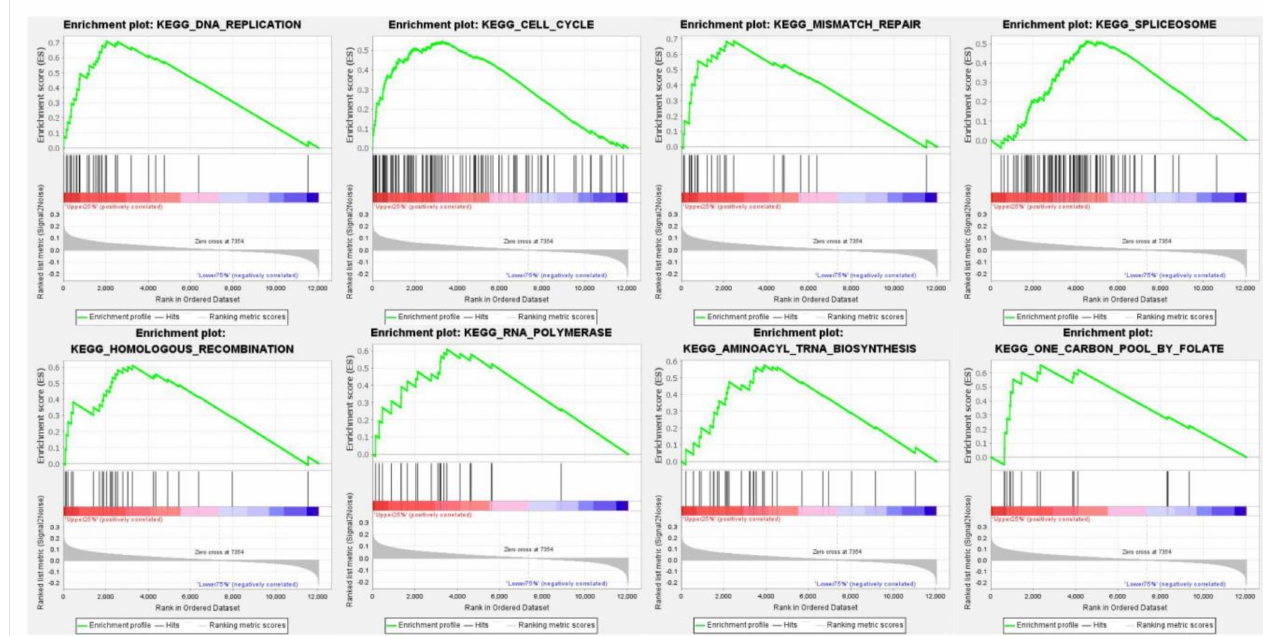
Figure 6. The pathway enrichment analysis of PUS7 in ovarian cancer. GSEA pathway analysis using TCGA ovarian cancer data, which was separated to a high (top25%) PUS7 group and a low (down75%) PUS7 group. Eight top pathways in which PUS7 participates were DNA replication, the cell cycle, mismatch repair, spliceosomes, homologous recombination, RNA polymerase, aminoacyl, tRNA biosynthesis, and one carbon pool by folate in ovarian